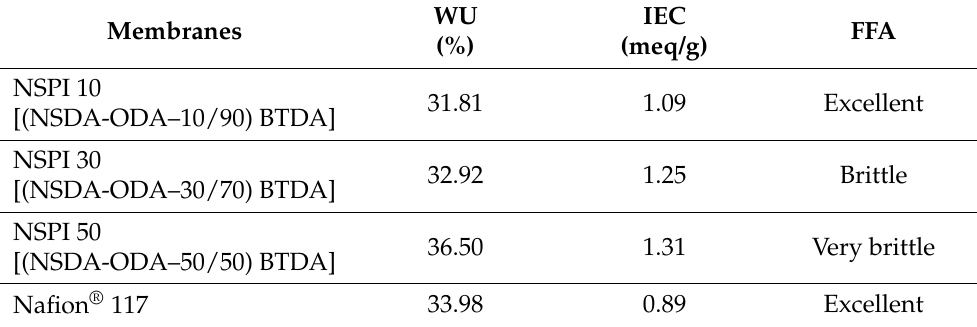
Table 1. Water uptake, ion exchange capacity, and film=forming ability of NSPI membranes.